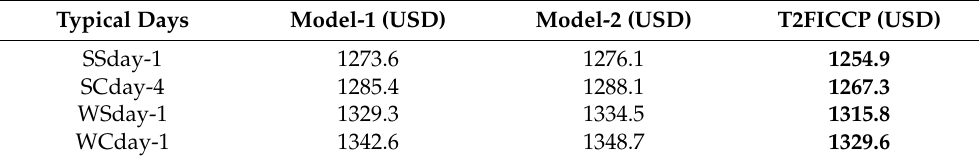
Table 1. Scheduling costs of different models for the same typical day ( β =